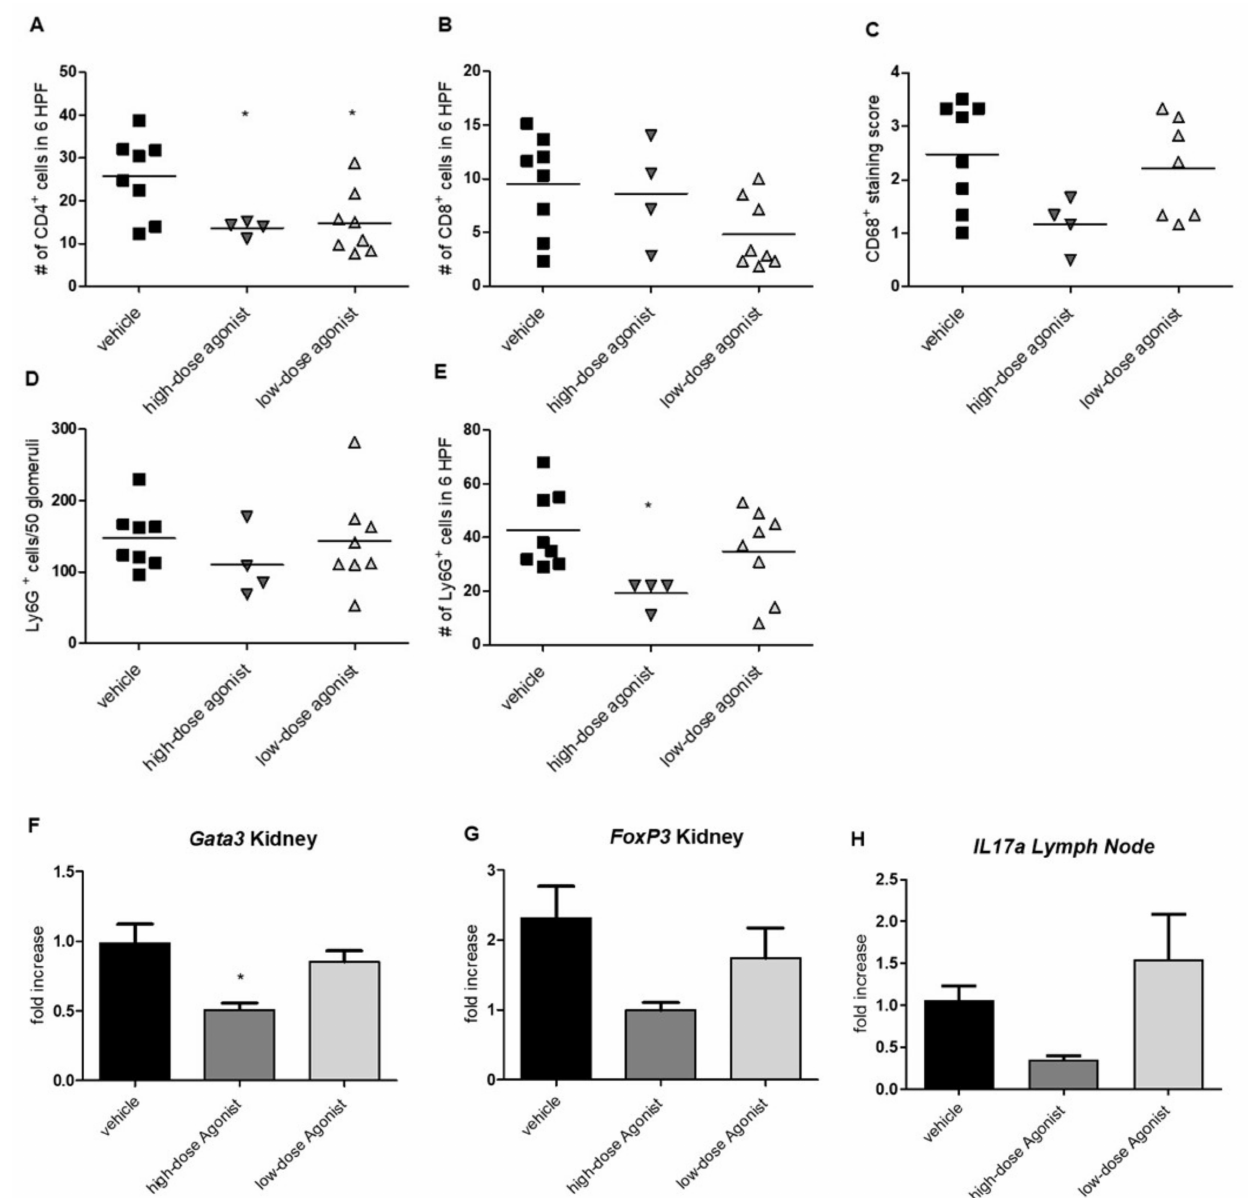
Figure 3. Effects of EP4 agonism on kidney-infiltrating immune cells. Fourteen days after induction of NTS, renal infiltration of CD4 + ( A ), CD8 + T cells ( B, ) and CD68 + macrophages ( C ) were evaluated in mice treated with high- and low-dose EP4 receptor agonist compared to vehicle. Ly6G + (Gr1) cells were evaluated in glomeruli ( D ) and the interstitium ( E ) on day 14 after NTS induction. Fourteen days after NTS induction, quantitative PCR was performed to evaluate Gata3 , FoxP3 , and Il17a expression in the kidney and lymph node ( F–H ) in mice treated with vehicle ( n = 6), high-dose EP4 receptor agonist ( n = 3–4), and low-dose EP4 receptor agonist ( n = 7–8). Results were compared to the kidneys of healthy mice ( n = 3). Data are provided (mean ± SEM) as fold increase compared to healthy kidneys. Means are indicated by a horizontal line. Statistical significances are provided compared to vehicle-treated mice (* p ≤